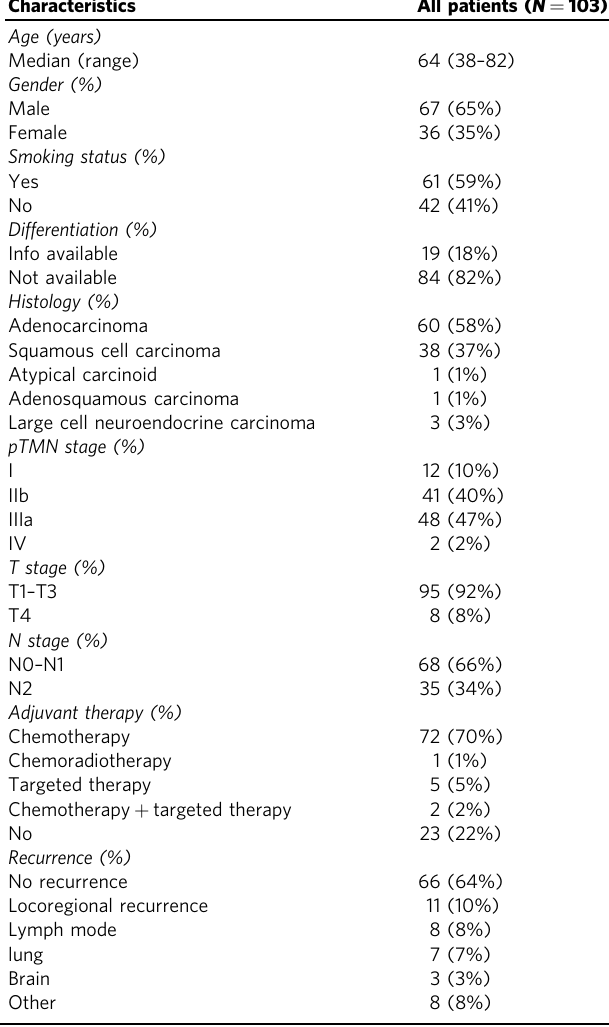
Table 1 Patient clinical characteristics.